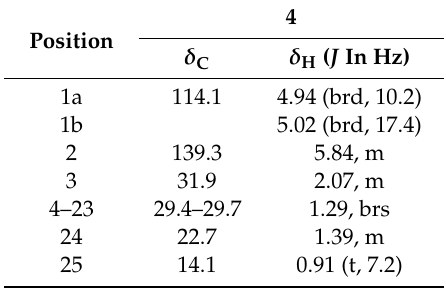
Table 4. 13 C– and 1 H–NMR (400 MHz) data of compound 4 in CDCl 3 .